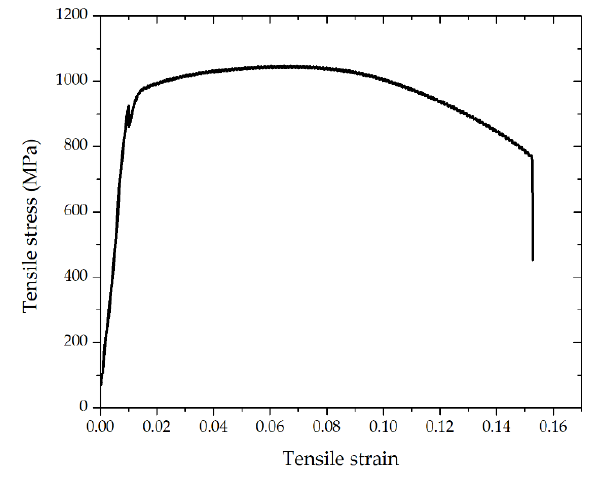
Figure 5. Tensile stress-strain curve.